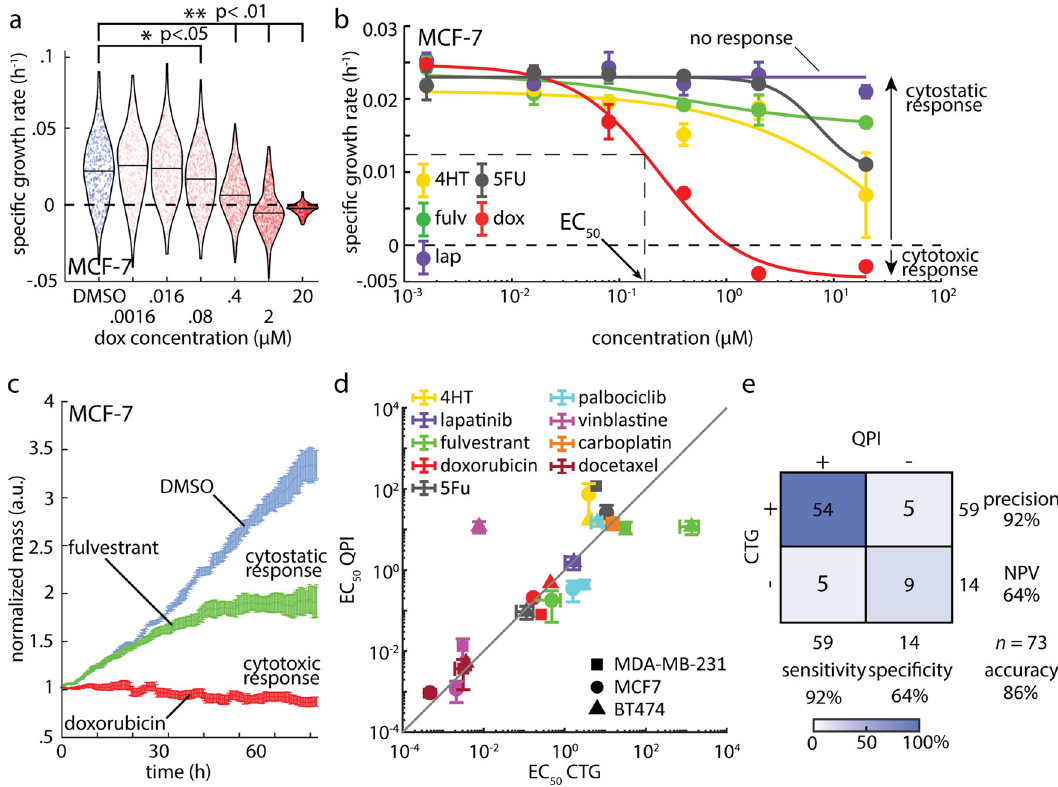
Fig. 2 Dose response measurement with QPI is concordant to CTG and also characterizes mechanism-dependent depth of response. a QPI measurements of the speci fi c growth rate distributions for MCF-7 cells at increasing concentrations of doxorubicin. Individual speci fi c growth rate measurements are indicated by points in the distribution. Blue: DMSO control, red: doxorubicin. Black outline is a kernel density function fi t to the distribution of speci fi c growth rates for each condition. * p < 0.05, ** p < 0.01. b Each point on the dose response curve represents the speci fi c growth rate of 450 – 700 MCF-7 cell clusters averaged over 27 individual imaging locations used to fi t a 4-point Hill equation to dose response data for measurement of EC 50 and depth of response. Color indicates drug. Cytostatic response is noted as a moderate decrease in SGR, while cytostatic responses are indicated by a minimum asymptote of the hill curve at or below zero. c Average mass normalized by the initial mass of each cluster versus time for 486 clusters in response to 20 μ M doxorubicin treatment, 615 clusters in response to 20 μ M fulvestrant, and 476 clusters treated with DMSO control. Cytostatic response can be observed as the population slows mass accumulation (fulvestrant) while a cytotoxic response results in a gradual loss of mass due to cell death (doxorubicin). d Comparison of EC 50 from Hill equation fi tting to CTG and QPI data. Gray line shows the expected relationship (EC 50,CTG = EC 50,QPI ). Color indicates drug, symbol indicates cell line. Correlation coef fi cient, R = 0.83, p = 7.5 × 10 − 7 , Concordance coef fi cient = 0.84. e Confusion matrix showing the precision and accuracy of QPI relative to CTG by comparing the frequency QPI predicts the same outcome as CTG. Error bars show standard error of the mean